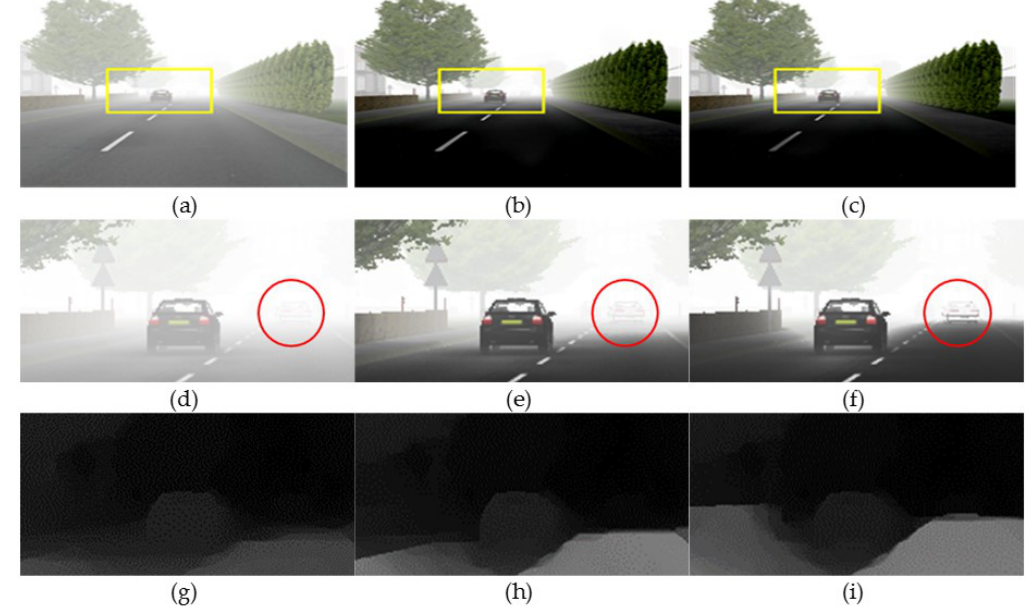
Figure 5. Defogging results of synthetic stereo image. ( a – c ) Input, 4-, and 7-th defogged images; ( d – f ) enlarged version of (a–c); and ( g – i ) corresponding transmission